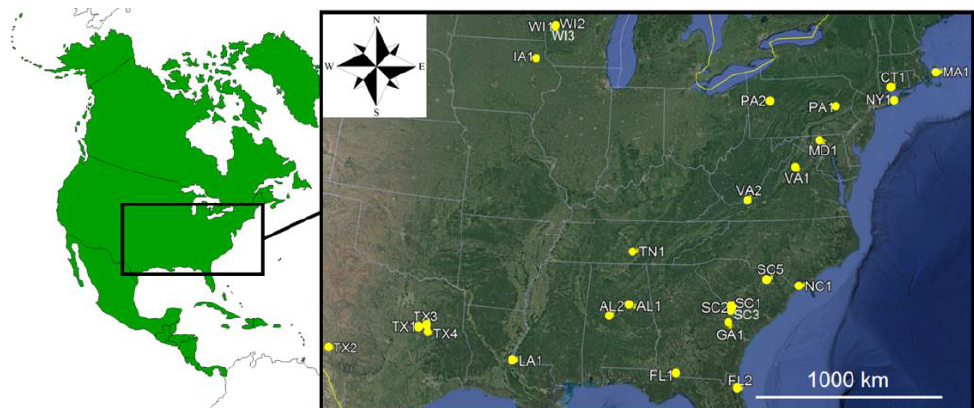
Figure 1. Sampling sites for Ixodes scapularis from the eastern U.S.A. (State codes as in Table 1).